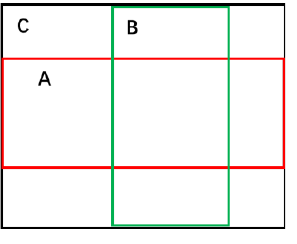
Figure 11. The calculation of GIoU.